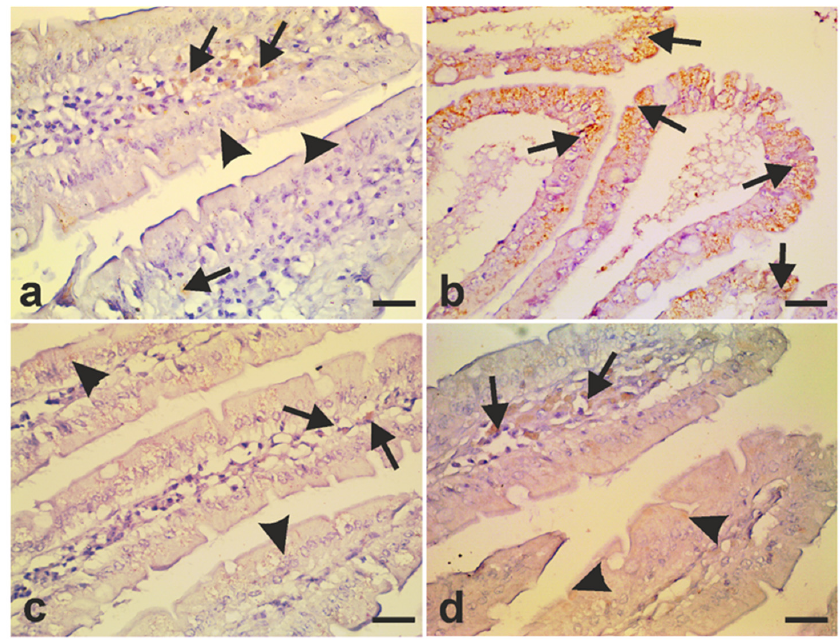
Figure 11. A. annua treatment of infected hamsters modulated iNOS expression in small intestine. ( a ) iNOS expression was localized in core intestinal cells of infected untreated animals (arrows) with no iNOS immunoreactivity in enterocytes. ( b ) Enterocytes showed high expression of iNOS in infected untreated animals (arrowheads). ( c ) Moderate iNOS expression was detected in core cells (arrows) as well as enterocytes (arrowheads) of intestines taken from infected animals that were treated with metronidazole. ( d ) Low iNOS expression was detected in villi core mononuclear cells of infected animals that were treated with A. annua extract (arrows) and was barely detected in enterocytes (arrowheads). Scale bar = 30 µm.